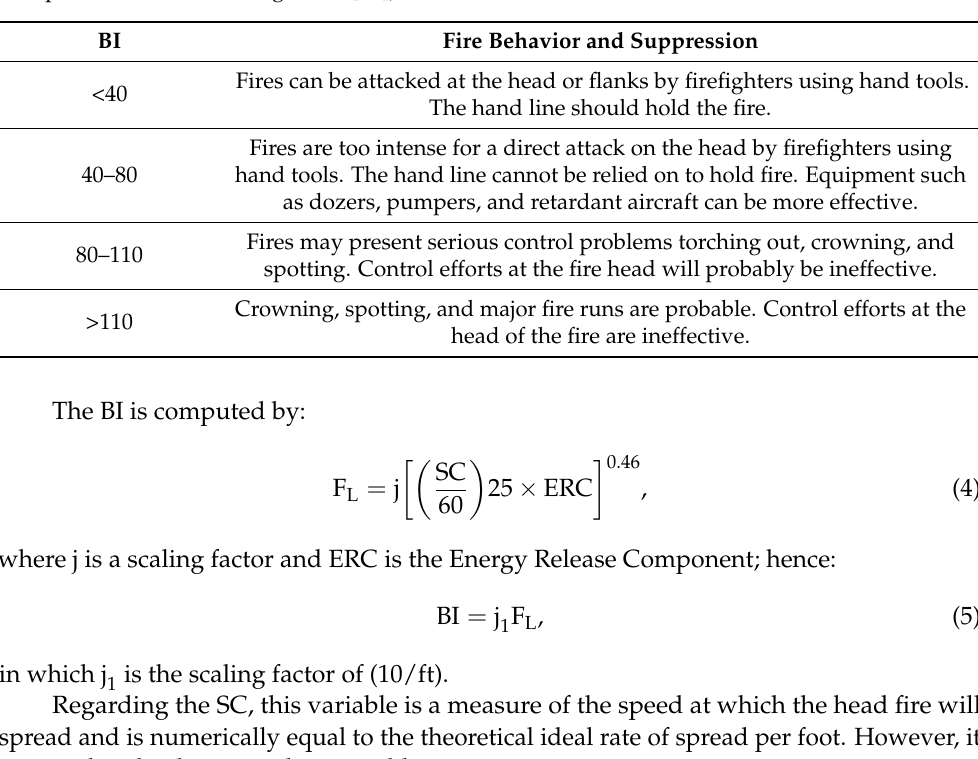
Table 3. Burning index (BI) scale and interpretation (adapted from the traditional U.S. Forest Service interpretation of the Burning Index